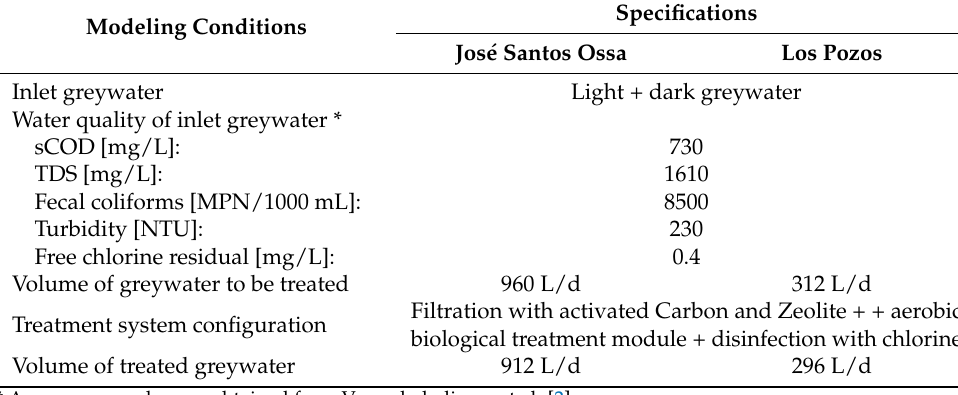
Table 2. Modeling conditions of scenario 2 (light + dark greywater